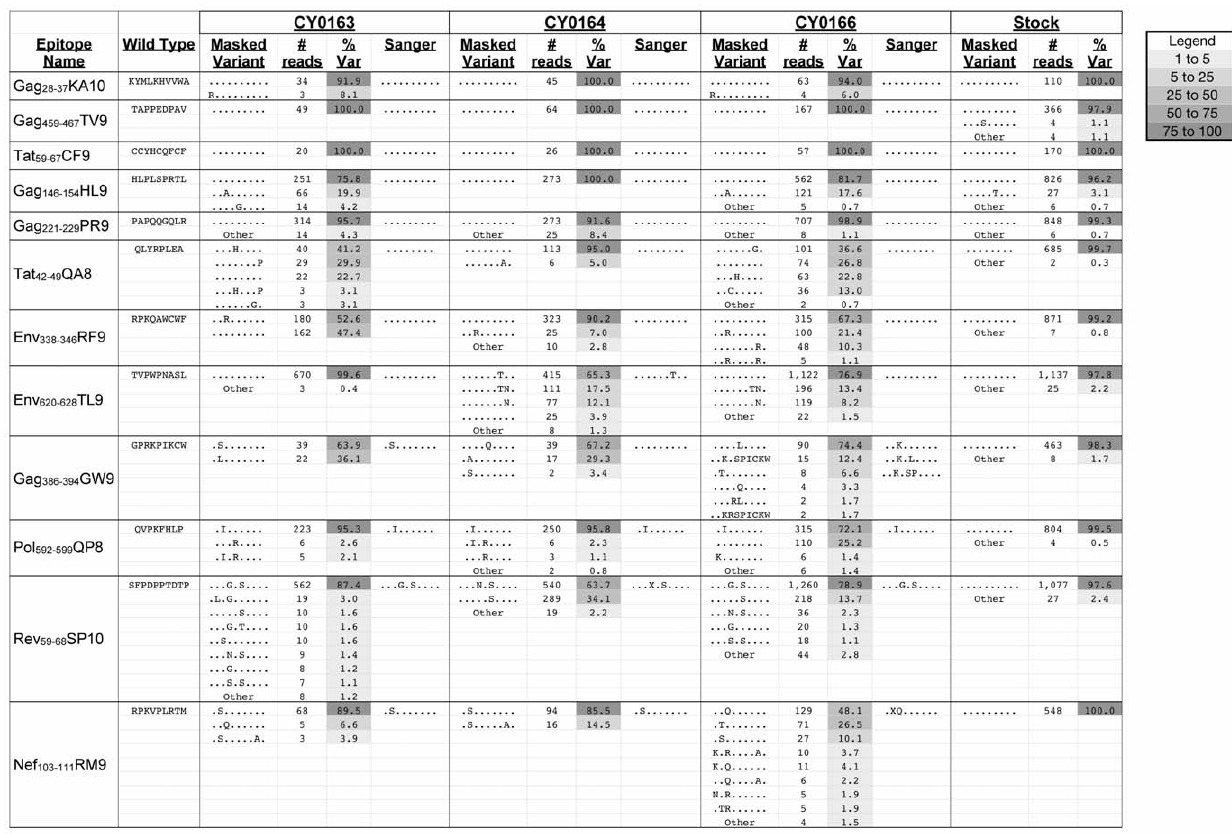
Figure 1. Variation in CD8-TL epitopes in virus populations from non-controller M3/M3 MCM and an SIVmac239 stock. Amino acid variation detectable by pyrosequencing in 12 CD8-TL epitopes in viruses isolated from three M3/M3 MCM (CY0163, CY0164, and CY0166) is compared to variation previously reported by Sanger sequencing bulk PCR amplicons [18]. Amino acid variants detectable within an SIVmac239 stock were characterized here and elsewhere [34]. Sequences that match the inoculum are represented with a ‘‘.’’. Mixed populations are represented with an ‘‘X’’. The number of high quality reads with each specific sequence is shown. The total number of reads for each epitope can be found in Table S2. The frequency of reads with a specific amino acid sequence is shown as ‘‘% Var.’’ The sequences labeled as ‘‘other’’ include variants that were individually present at less than 1% and variants that were also detected in the inoculum, which included the A2V mutation in Gag 221–229 PR9. The relative shading of each box reflects the frequency of reads, as indicated in the legend.